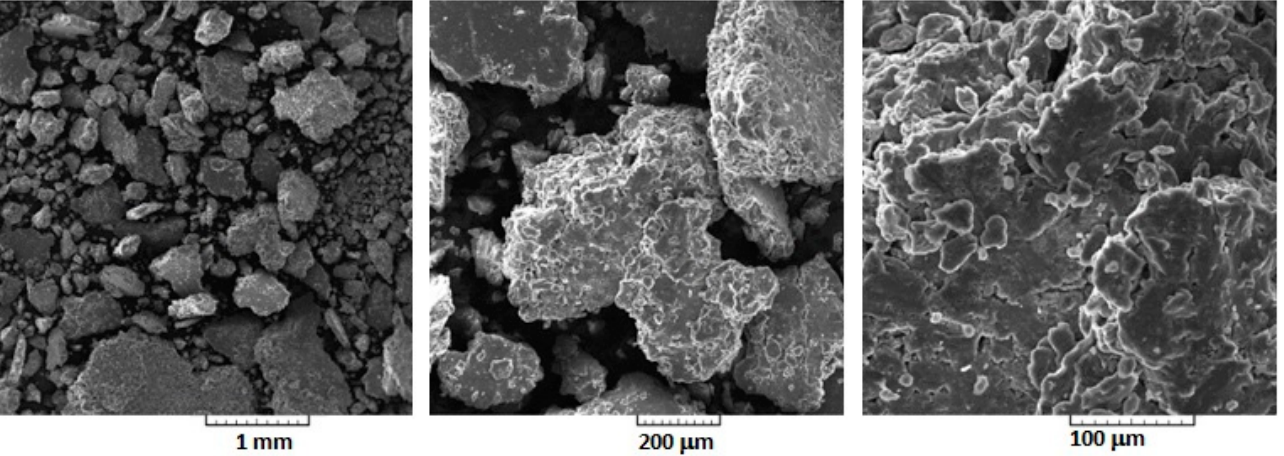
Figure 9. The Mg ‐ 10Zn ‐ 0.8Ca ‐ 0.5Zr (wt.%) alloy ‐ powder processed by mechanical alloying with 300 rpm/28 h/10:1.